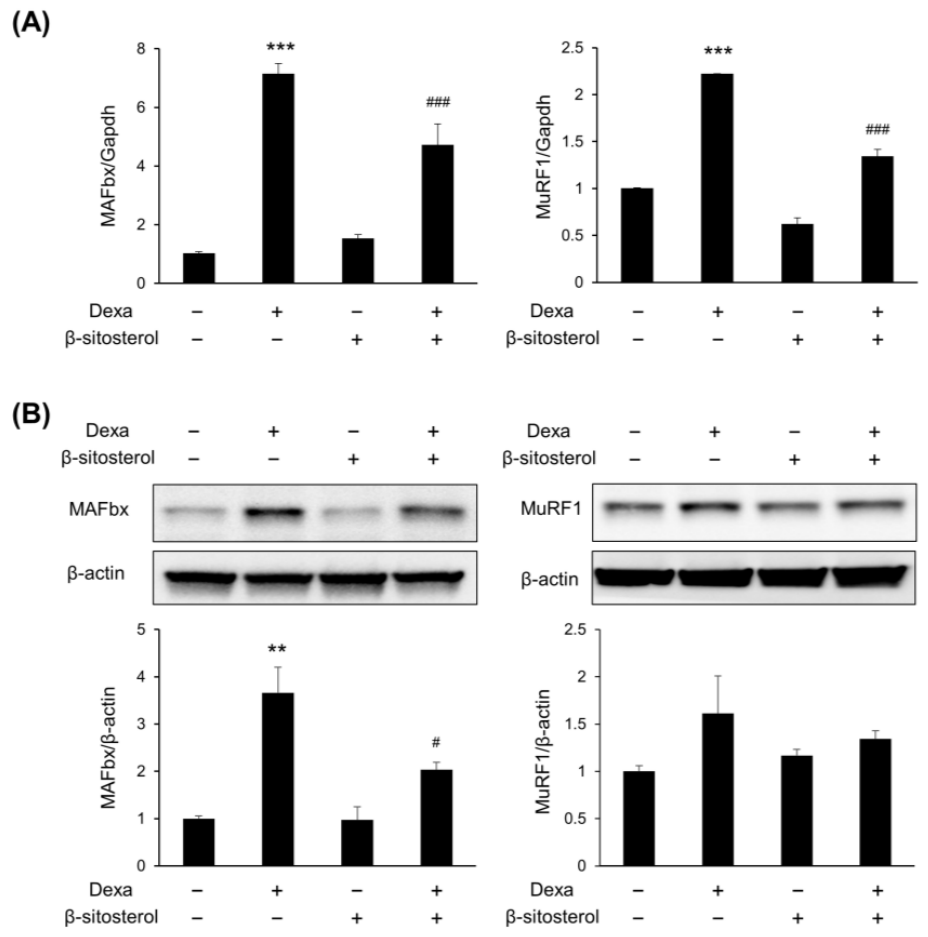
Figure 4. β -sitosterol suppresses the expression of MAFbx and MuRF1. C2C12 myotubes were treated with 0.5 mM β -sitosterol in the presence or absence of 1 µ M Dexa for 48 h. ( A ) MAFbx and MuRF1 mRNA levels were analyzed by quantitative PCR. GAPDH was used as a control. Data are shown as mean ± S.D. ( n = 4 per group). *** p < 0.001 vs. control; ### p < 0.001 vs. Dexa. ( B ) The expression of MAFbx and MuRF1 protein in C2C12 myotubes was estimated by Western blot analysis. β -actin was used as a control for protein loading. ** p < 0.01 vs. control, # p < 0.05 vs. Dexa.